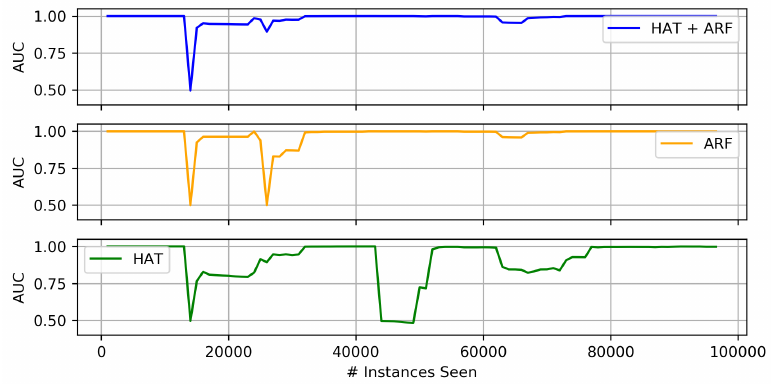
Figure 5. Comparison of HAT + ARF ensemble and their individual component performances on HTTP.